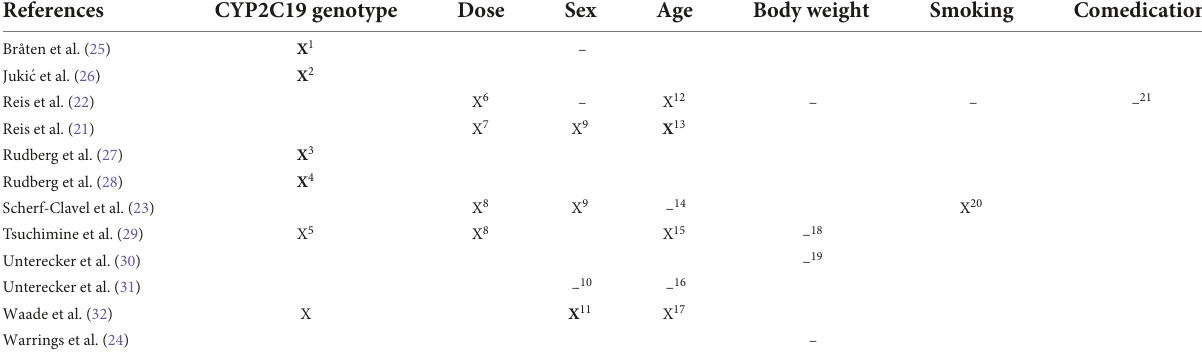
TABLE 3 Factors influencing ESC serum concentration